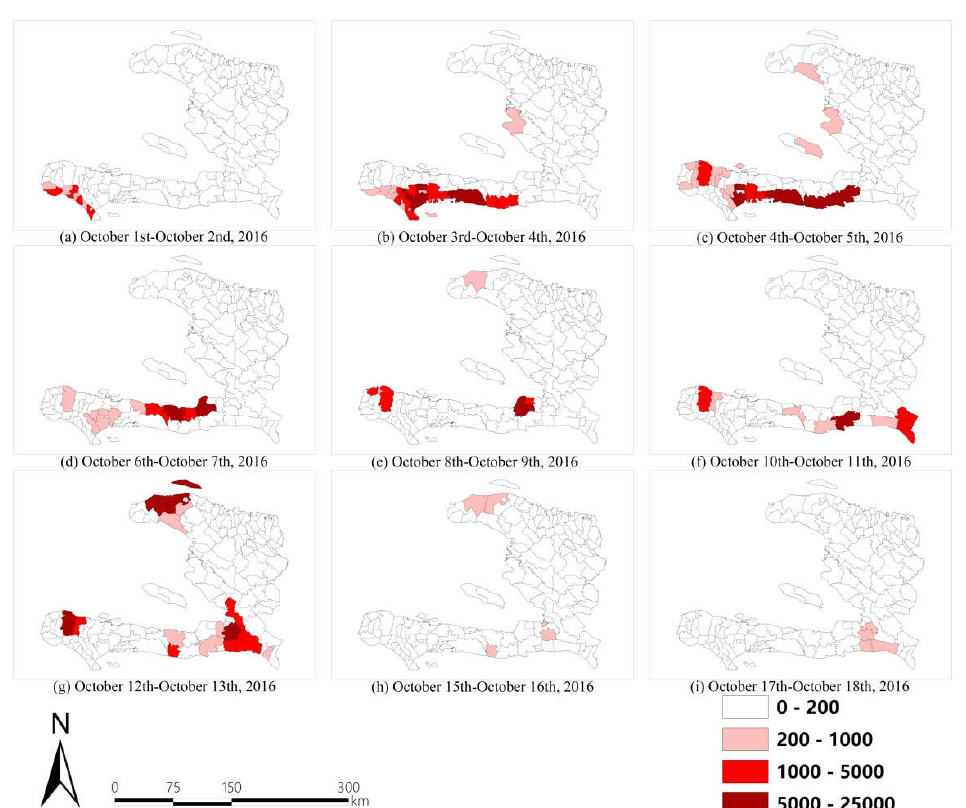
Figure 4. Number of buildings updated in every commune in